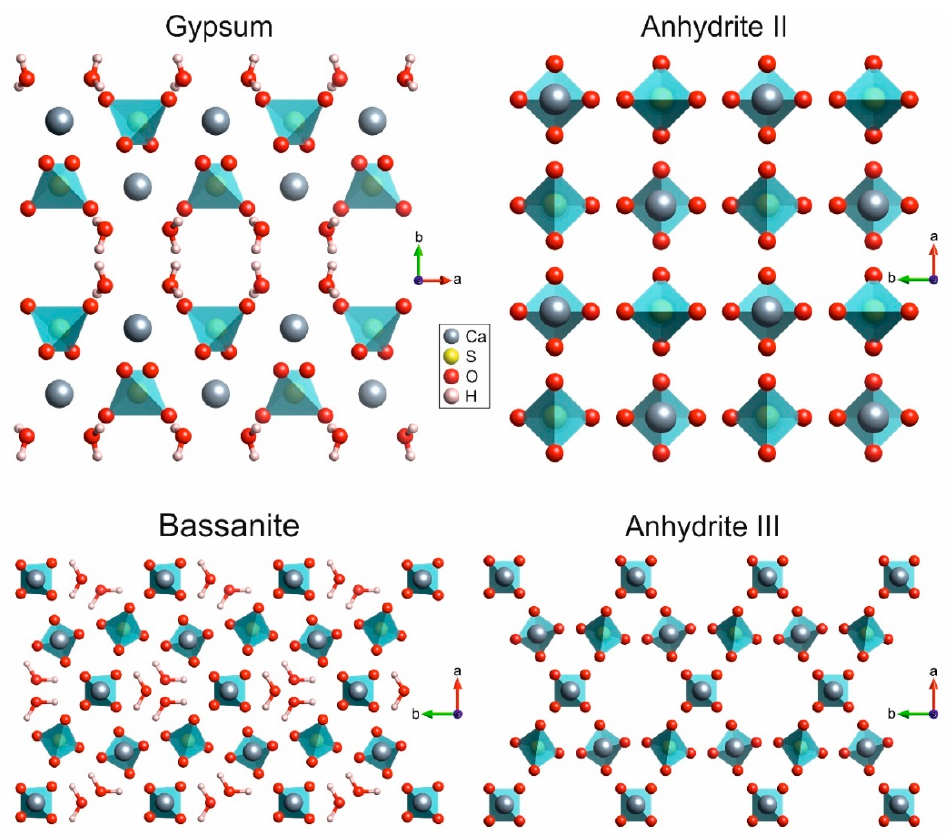
Figure 1. Crystal structures of the four main phases of the CaSO 4 –H 2 O system, which are stable at room temperature. The graphical representations were designed by employing the software VESTA (Visualisation for Electronic and STructural Analysis) [14] and structural data available in References [15–18].